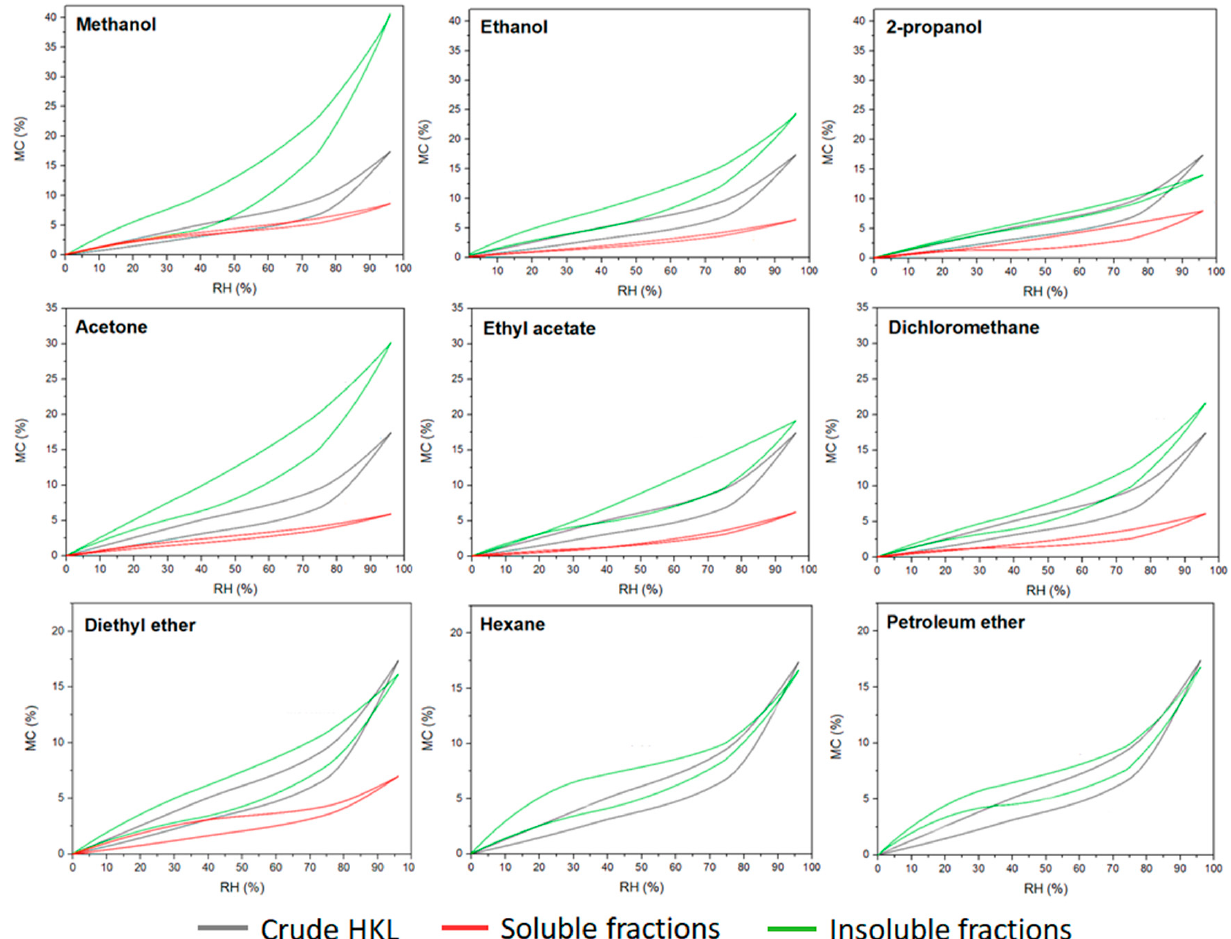
Figure 4. Experimental sorption–desorption isotherms of lignin fractions determined by saturated salt solution method.